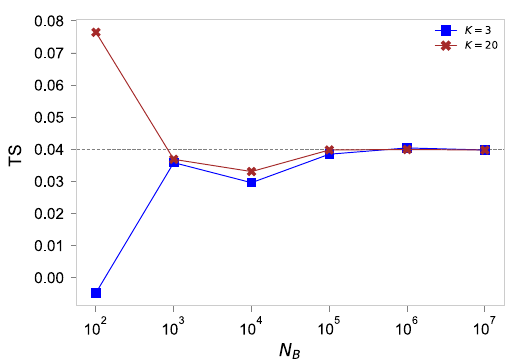
Fig. 2 Convergence of the test statistic to the exact KL divergence (dashed horizontal line) between two 2-dimensional Gaussian distribu- tions, in the large-sample limit. The B , T samples have the same size N B = N T , and they are sampled from 2-dimensional Gaussian distri- butions with µ B = 1 . 0 2 , µ T = 1 . 2 2 , (cid:10) B = (cid:10) T = I 2 . Two different choices for the number of nearest neighbors are shown: K = 3 (blue squares) and K = 20 (red crosses) Table 3 Definition of the Gaussian datasets used for the numerical experiments. Each sample consists of N B = N T = 20 , 000 points randomly drawn from D -dimensional Gaussian distributions N ( µ ,(cid:10)) Dataset µ